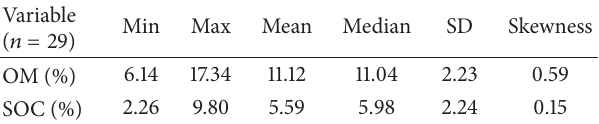
Table 2: Descriptive statistics of organic matter (OM) obtained by loss on ignition (LOI) and soil organic carbon (SOC) obtained by gas analyzation for the 0–10cm